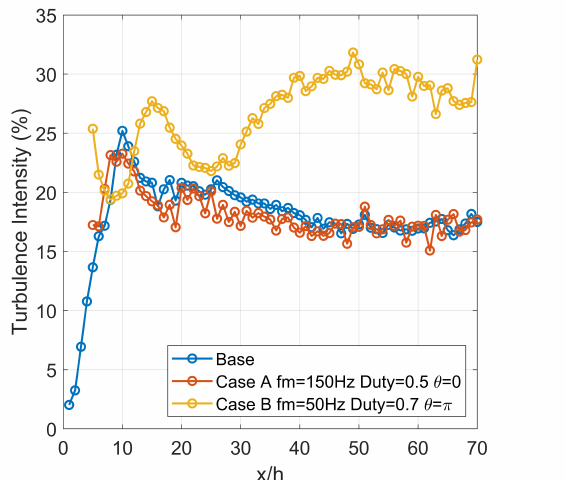
Figure 15. Comparison of centerline turbulence intensity between cases. Plasma Actuators can influence the distribution in the oy and oz direction, as shown in Figure 16. In case A, velocity profiles along the z-axis were improved at all measured locations; the y profiles were decreased at x / h equaled 5 and 10 and had positive offsets at x / h = 30, 50, and 70. In the case of B, the velocity profiles in the z-direction performed better than other cases from x / h = 5, 10, and 30, whereas the profiles in the y-direction performed worse than others. The jet width was expanded in the oz direction and constrained in the oy direction, indicating the conversion of kinetic energy from one direction to the other. The cross-section of a rectangular jet evolves downstream with its major and minor axis rotated at angles compared to jet geometry. This phenomenon is called